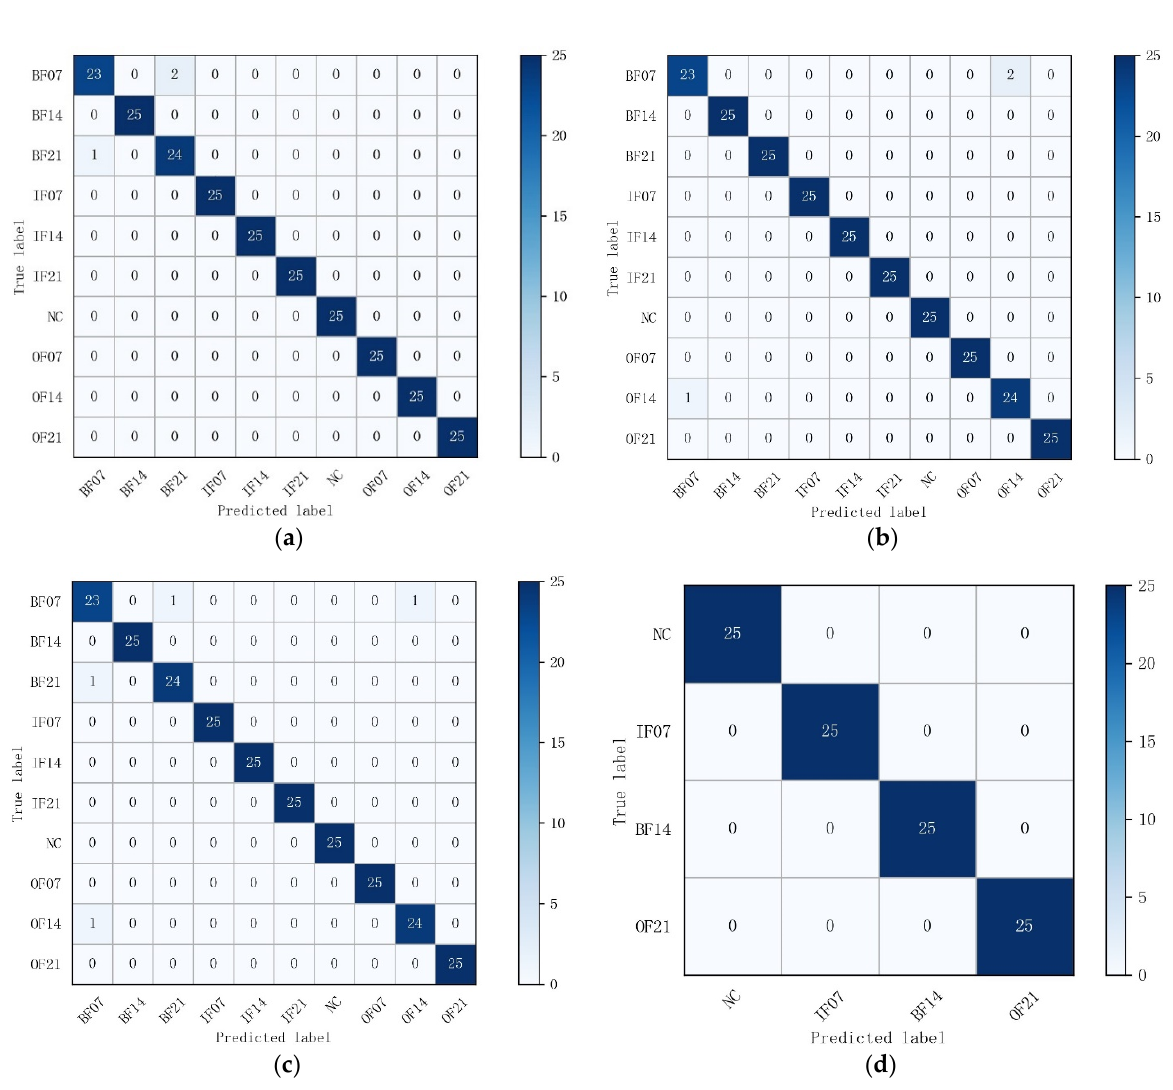
( d ) Figure 8. Feature visualization by t-SNE for each dataset: ( a ) Dataset A; ( b ) Dataset B; ( c ) Dataset C; ( d ) Dataset D.